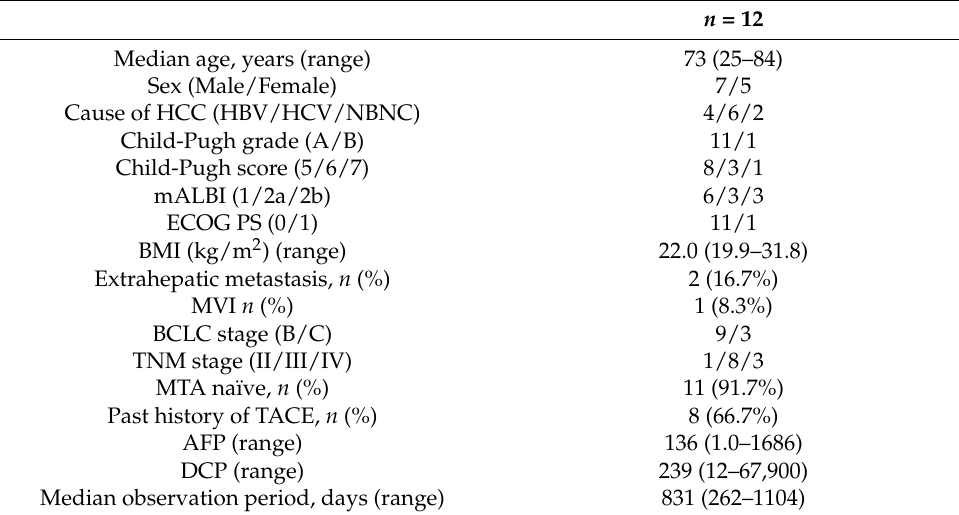
Table 1. Characteristics of HCC patients who achieved a complete response following lenvatinib